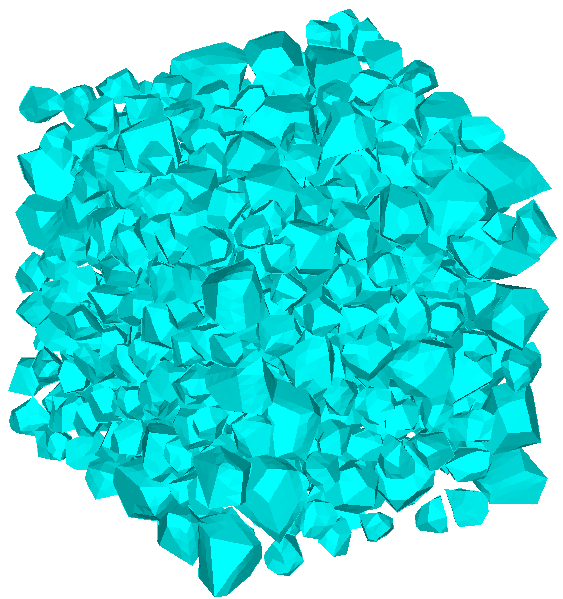
Figure 10. A simulated model after free falling.